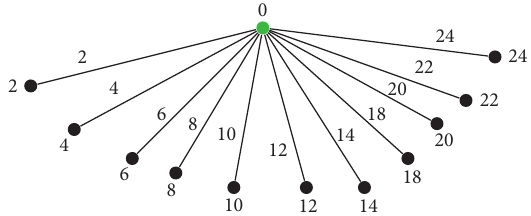
Figure 4: A 3-edge even labeling of the graph K Illustration . A 3-edge even labeling of the comb graph P ⊙ K is shown in Figure 6. 10 1